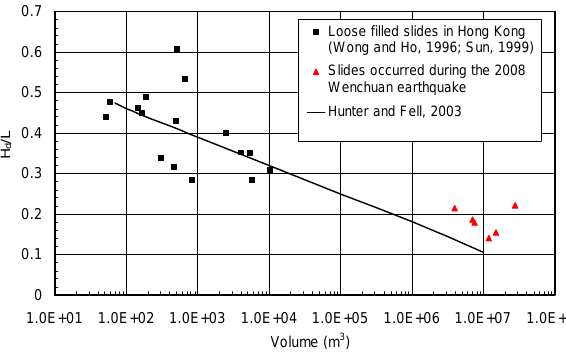
Fig. 13. An empirical model for predicting run-out distances of loose deposits.